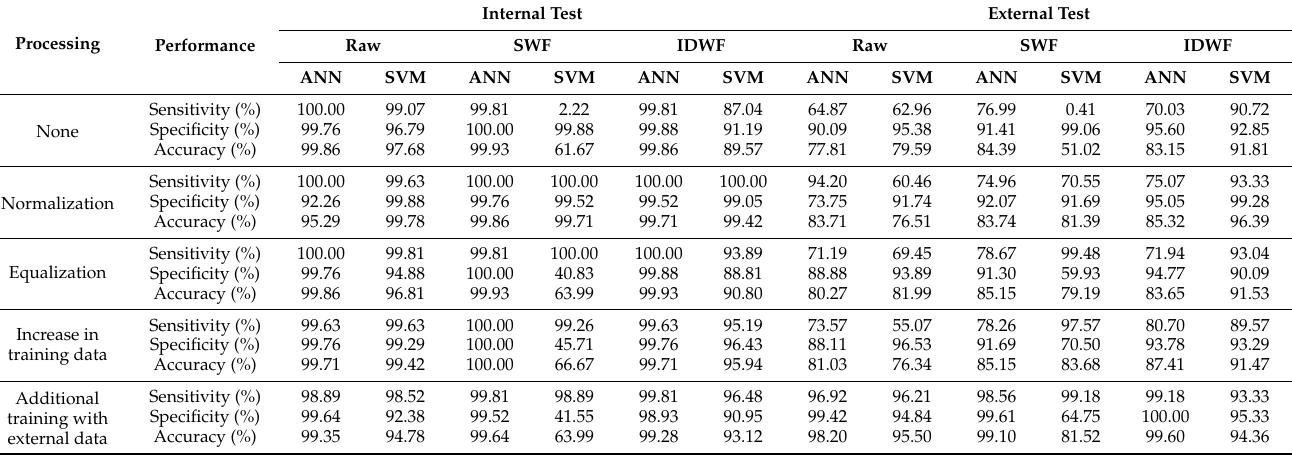
Table 3. Performance of ANN and